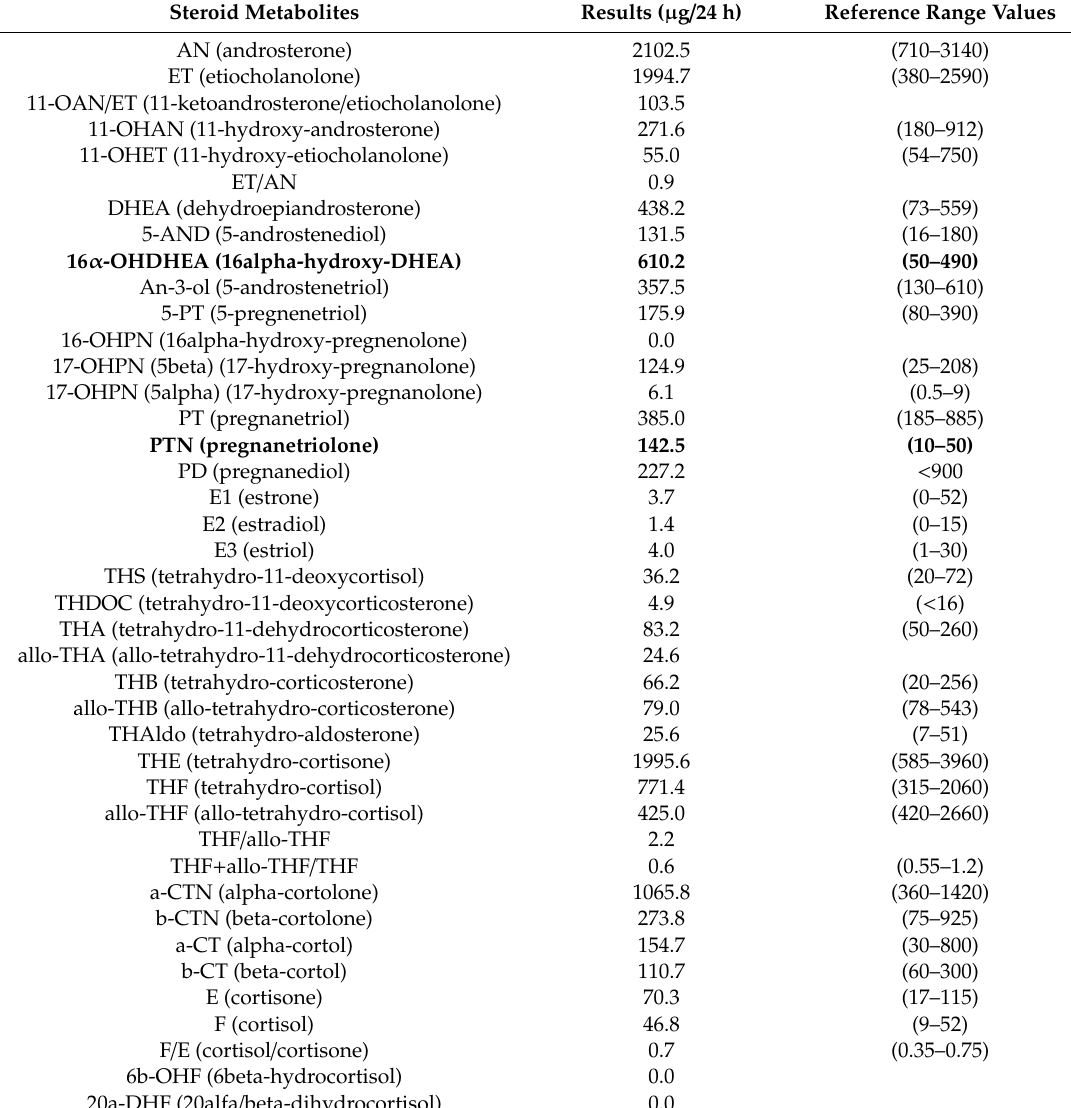
Table 4. Steroid profile in 24-h urine collection (gas chromatography mass spectrometry,